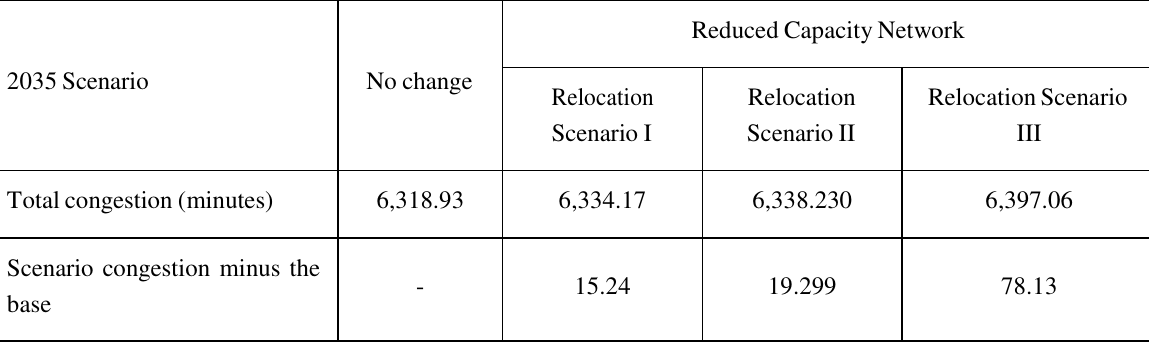
Table 5. Summary of the model results for the total